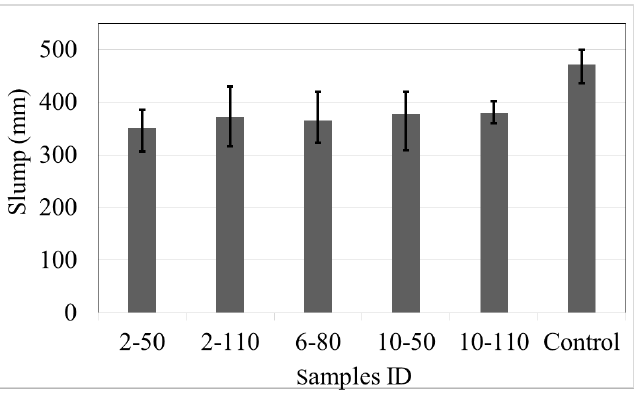
Figure 4. Slump results of control samples and concrete with recycled PET fibres. The results indicate that control samples had a slump value of 472 mm, which is 22% superior that the mean of batches with recycled PET fibres. Also, the incorporation of re- cycled PET fibres to the concrete augments the variation in the slump response. On the other hand, the effect of the fibre dose and aspect ratio on the workability is scarce, with a maximum difference of 7.6%. Highlighting that the batches with the highest recycled PET fibre dose and aspect ratio demonstrated the best slump, a phenomenon attributed to the low rigidity of the recycled PET fibres [36]. 4.2. Compressive Behaviour Concrete cylinder specimens of 100 × 200 mm (diameter and length, respectively) were tested according to ASTM C39 [37]. The deformation was measured with a plunger dial indicator located on the structure of the universal testing machine since the displace- ment of the load plates has a direct relation with the deformation of the sample. The dial indicator covered a measuring range from 0 to 25 mm with resolution of 0.25 µm and accuracy of ±0.25 µm. Figure 5 shows the compressive stress-strain curves of the control concrete and those with recycled PET fibres. For each combination of fibre dose and aspect ratio, a curve was represented with the average strengths of 5 samples to show very visually the typical be- haviour of each concrete. In general, the graphs show that the R/PET-FRC specimens had a scarce reduction on the ultimate compressive strength than control samples, but the in- corporation of the PET fibres generated in the concrete an augment on the compressive toughness. Figure 5. Compressive stress-strain curves of control samples and concrete samples with recycled PET fibres.